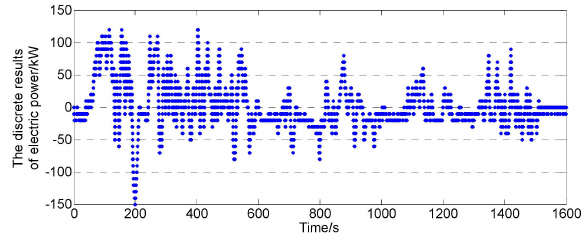
Figure 15. The discrete results of electrical power.